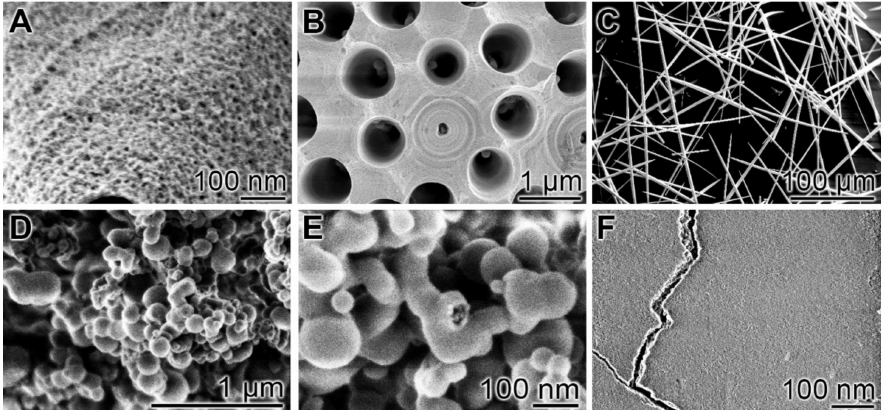
Figure 3. Biosilica and polyP based materials; scanning electron microscopy (SEM) analysis. ( A – C ): Biosilica. ( A ) Fusion of silica particles under ( B , C ) formation of solid silica structures. In ( B ), a sterraster of the demosponge Geodia cydonium and in ( C ) spicules of the demosponge S. domuncula are shown. The sterraster in ( B ) has been broken to make the silicatein axial filaments visible in the centers of the holes (axial canals). ( D – F ): PolyP. ( D , E ) Amorphous Ca-polyP nanoparticles (different magnifications. Adapted with permission from ref. [87]. Copyright 2018, John Wiley and Sons. ( F ) Coacervate formed by